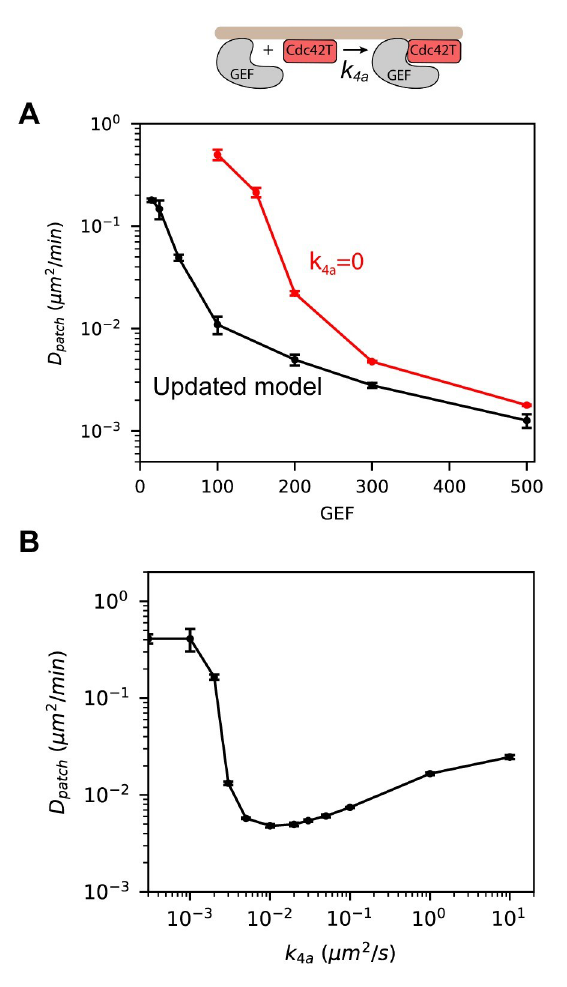
Fig 8. Increasing the rate constant of Cdc42T-GEF m association ( k 4a ) induces an abrupt change in patch mobility. (A) Patch centroid diffusivity as a function of the number of GEF molecules for the model that includes Reaction 7 (Updated model, black) and the same model but setting k 4a = 0 (red). (B) Patch diffusivity as a function of k 4a for simulations with GEF = 100. Error bars are standard errors from the least-squared fit used to compute D